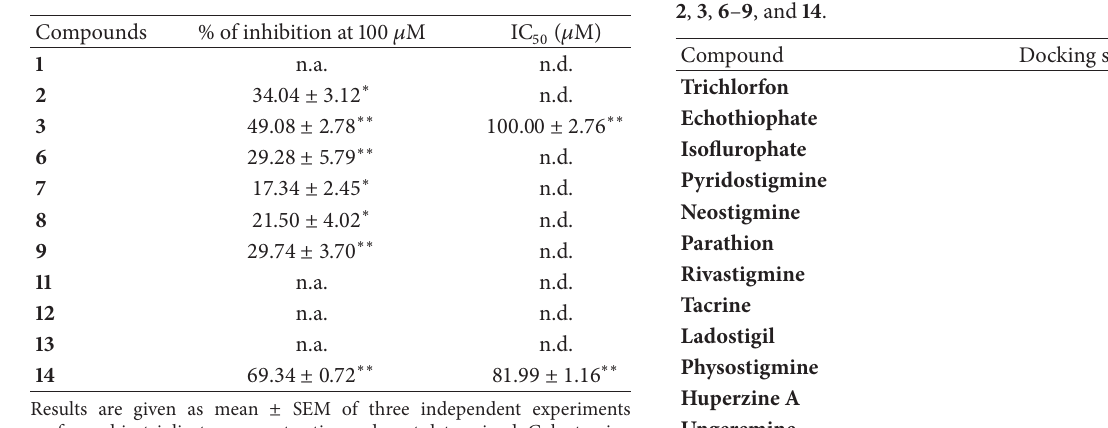
Table 3: AChE inhibitory activity of tested compounds. Compounds